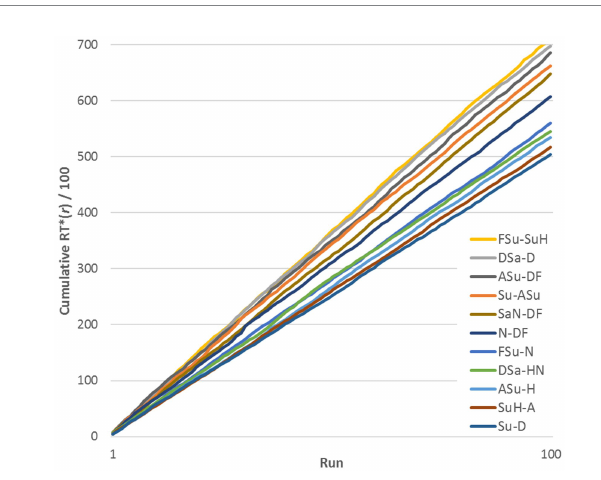
FIGURE 2 Cumulative sum of RT ij *( r ) across 100 runs for 11 representative stimulus pairs (exemplified by data for DK, Upright stimuli).